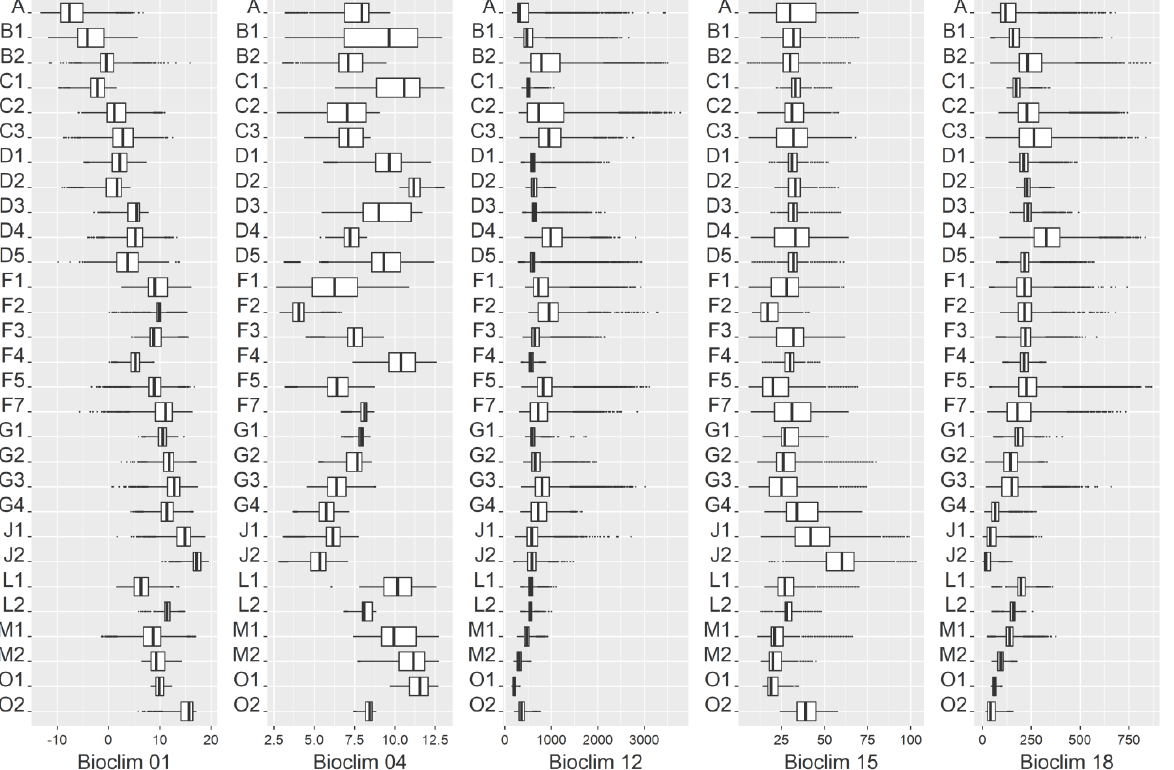
Figure 1. Boxplots of the climatic range of the CaPV classes within the parameters. Bioclim 01 = annual mean temperature (°C); Bioclim 04 = temperature seasonality (Std (monthly means)); Bioclim 12 = annual precipitation (mm/year); Bioclim 15 = precipitation seasonality (CV); Bioclim 18 = precipitation of warmest quarter (mm/quarter). Specifications of the CaPV classes are given in Table 1.